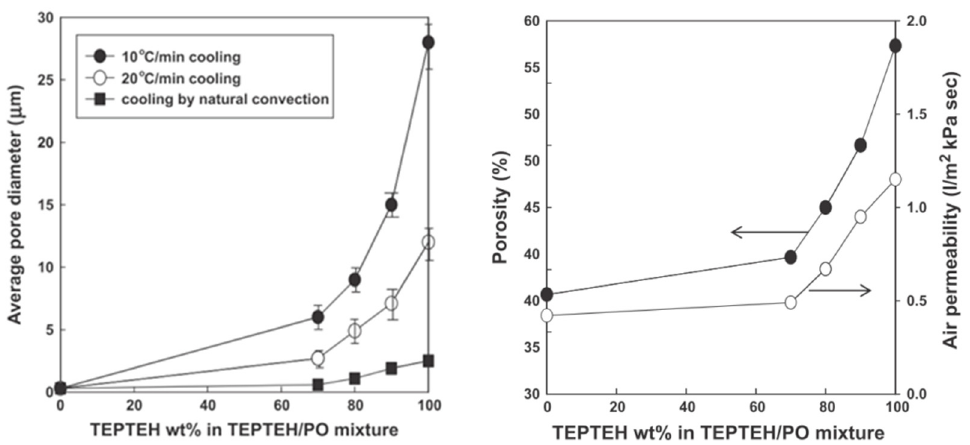
Figure 11. Changes in the membrane morphology and the performance when fabricated from PE // (TEPTEH / PO) = 30 / 70 blends as a function of triethylolpropane-tris(2-ethylhexanoate) (TEPTEH) content in the diluent mixture: ( left ) average pore diameters and ( right ) porosity and air permeability, adapted from [52] .